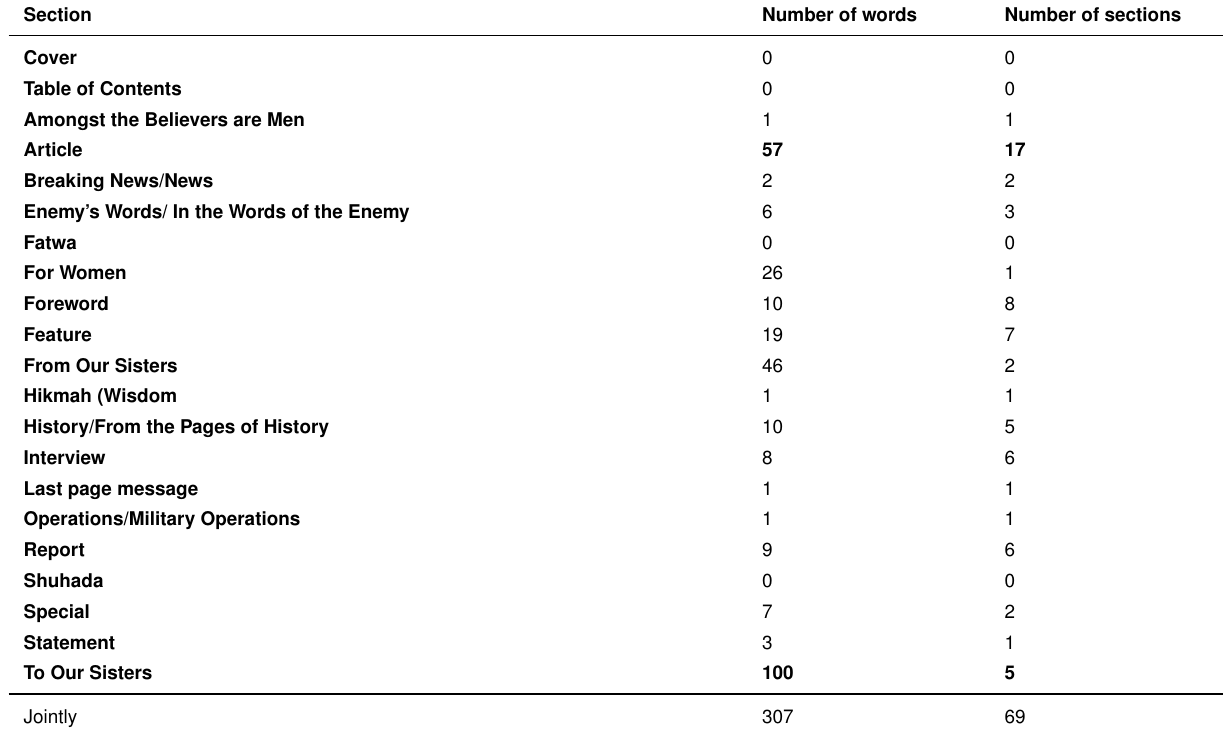
Table 2. The number of keywords and sections used in the Dabiq magazine.